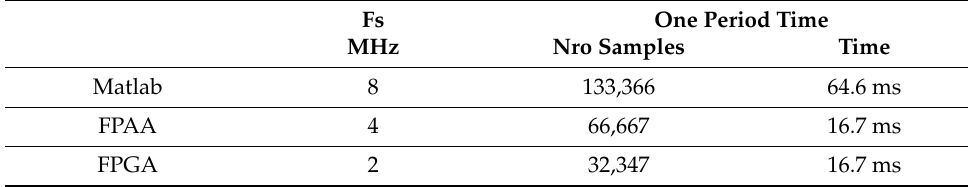
Table 5. Time performance